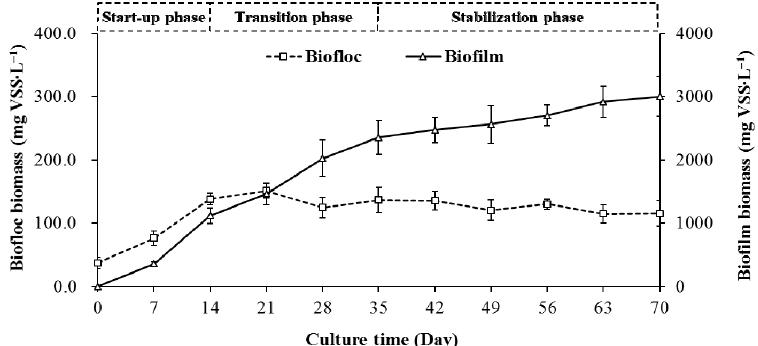
Figure 2. Biomass variation of biofloc in shrimp culture tank and biofilm in external aerated biofilter in the biofloc-RAS during a 70-day production trial (mean ± S.D., N = 3).